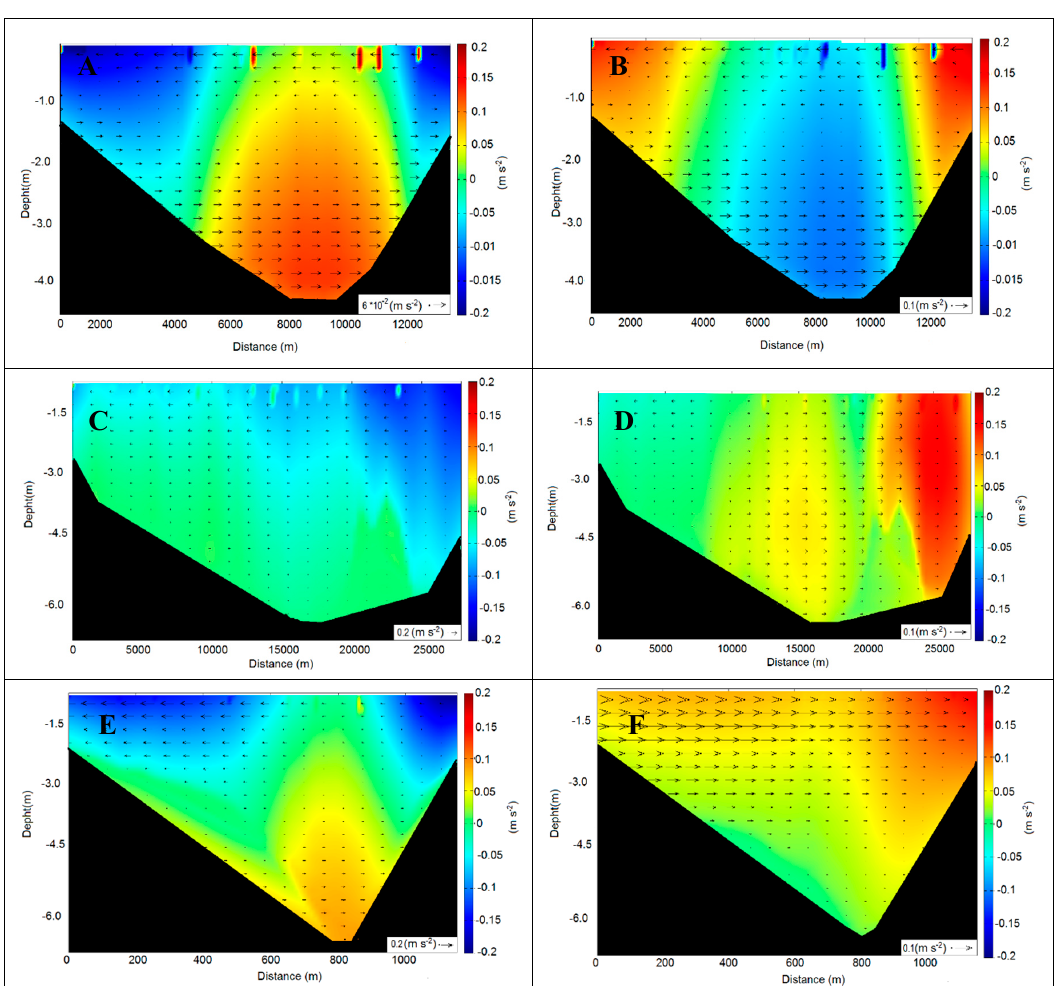
Figure 11. Velocity profiles during maximum northeastern (left column) and southwestern (right column) winds for T1 ( A, B ), T2 ( C, D ), T3 ( E, F ) transects. Transversal velocities are represented by the vectors (different scales for better visualization), whereas longitudinal velocities are represented by the color pallet. Northward flux is shown in red colors, while southward flux is shown in blue colors.